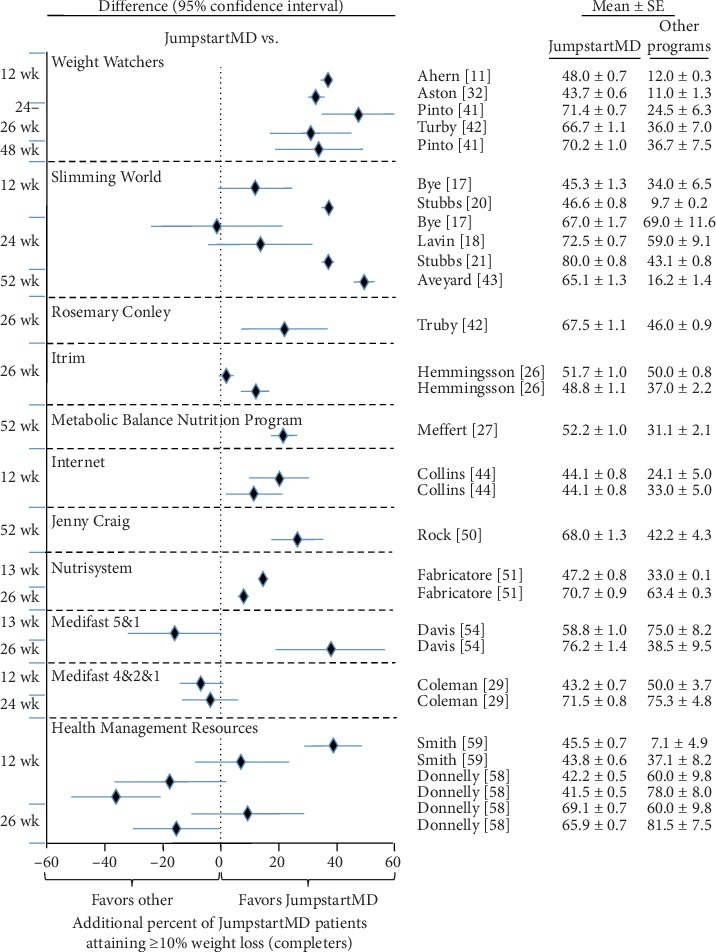
Mean weight loss difference between JumpstartMD and other commercial programs in completers as measured by percent attaining ≥10% weight loss. Positive differences designate greater JumpstartMD weight loss. See legend to Figure 5 for further explanation.